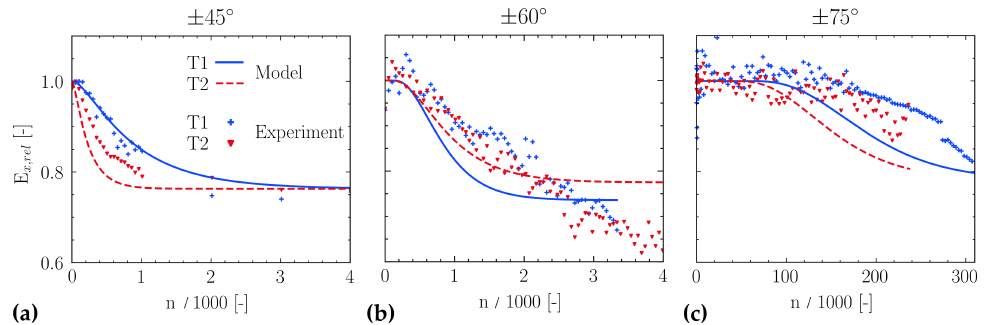
Figure 7. Stiffness degradation for the individual tests and damage model results. Comparison